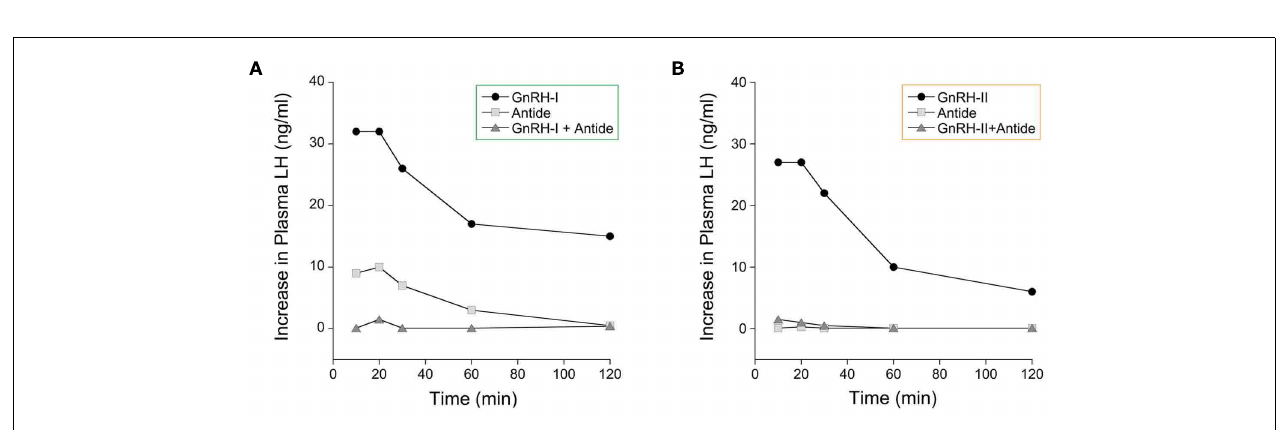
FIGURE 2 | Differential distribution of GnRH-I and GnRH-II mRNA in the rhesus macaque hypothalamus, as revealed by in situ hybridization histochemistry. (A) Line drawing showing hypothalamic region (in box). (B) Autoradiographs showing GnRH expression in the rostral (upper panels) and